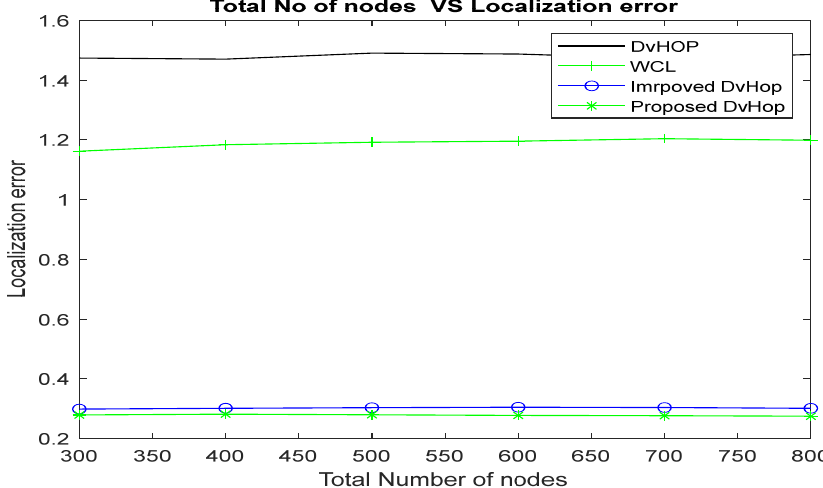
Table 9. Comparison of localization error using various total numbers of nodes . No. of Nodes